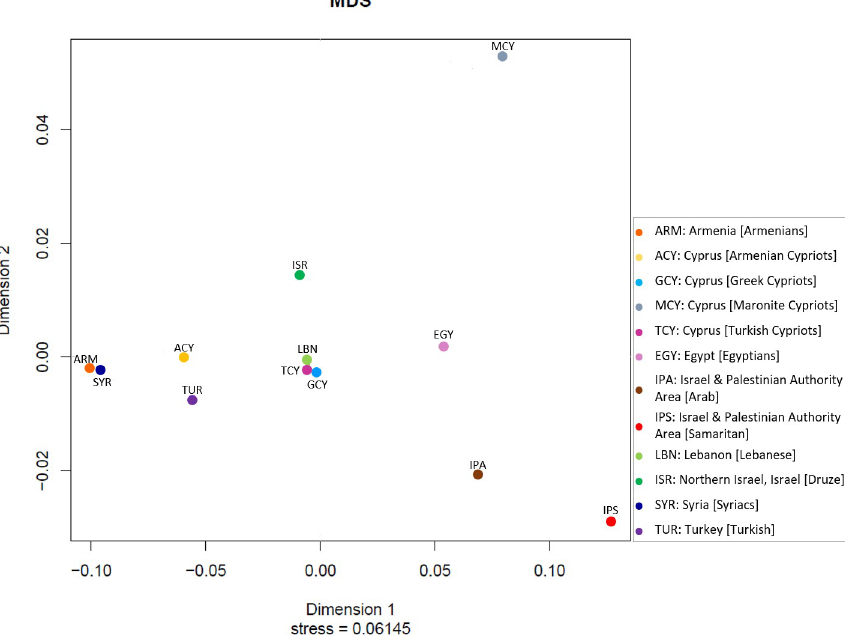
Fig 1. Multidimensional scaling plot between Cypriots and populations of interest. The measure of goodness of fit in MDS is called stress and stress values below 0.15 represent a good fit of the Rst values of the genetic distances in the plot. The value is 0.06145 confirming the good fit of the Rst values between the populations in the plot.